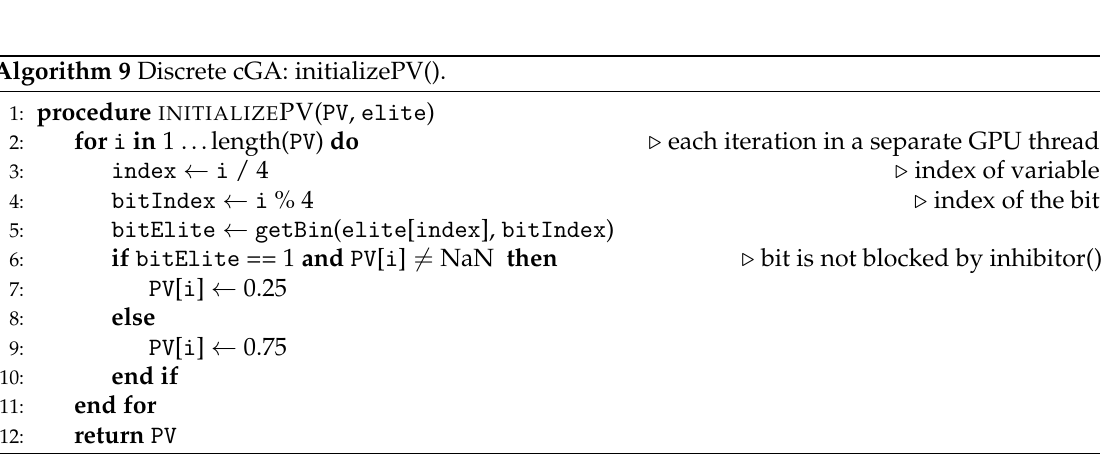
Algorithm 9 Discrete cGA: initializePV().